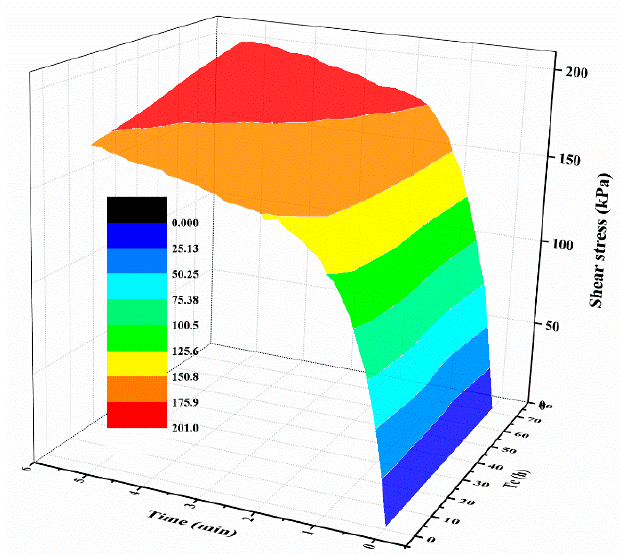
Figure 5. The typical shear curves:( a ) With different normal stress σ ; ( b ) With different curing times T c .